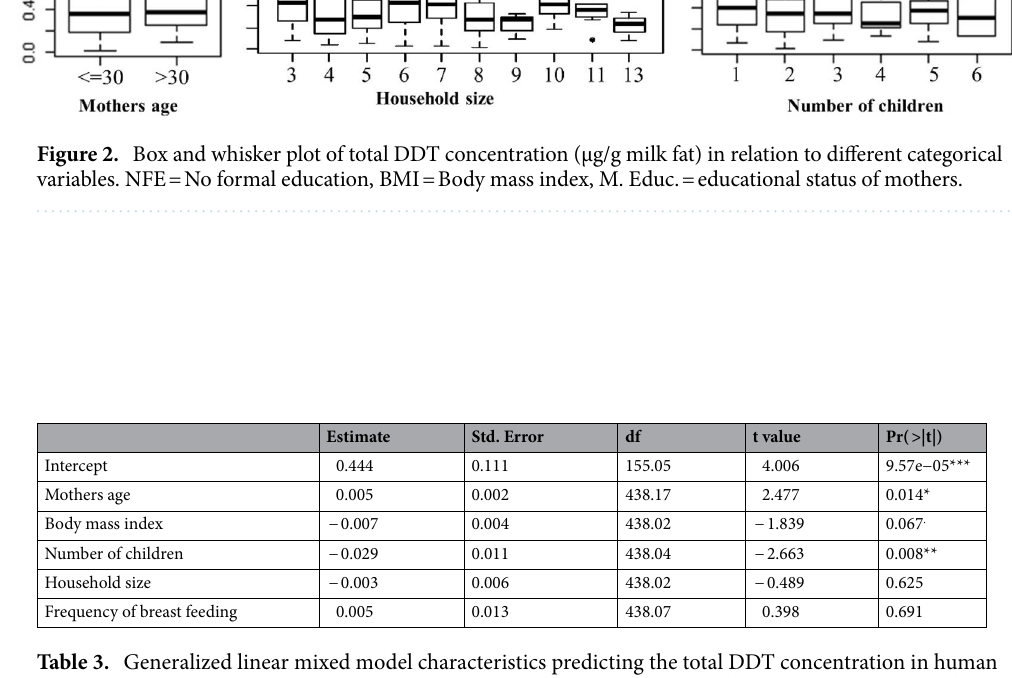
Table 3. Generalized linear mixed model characteristics predicting the total DDT concentration in human milk samples with demographic characters of mothers. Level of significance: ‘***’p < 0.001, ‘*’ p < 0.05, ‘.’ p < 0.1.